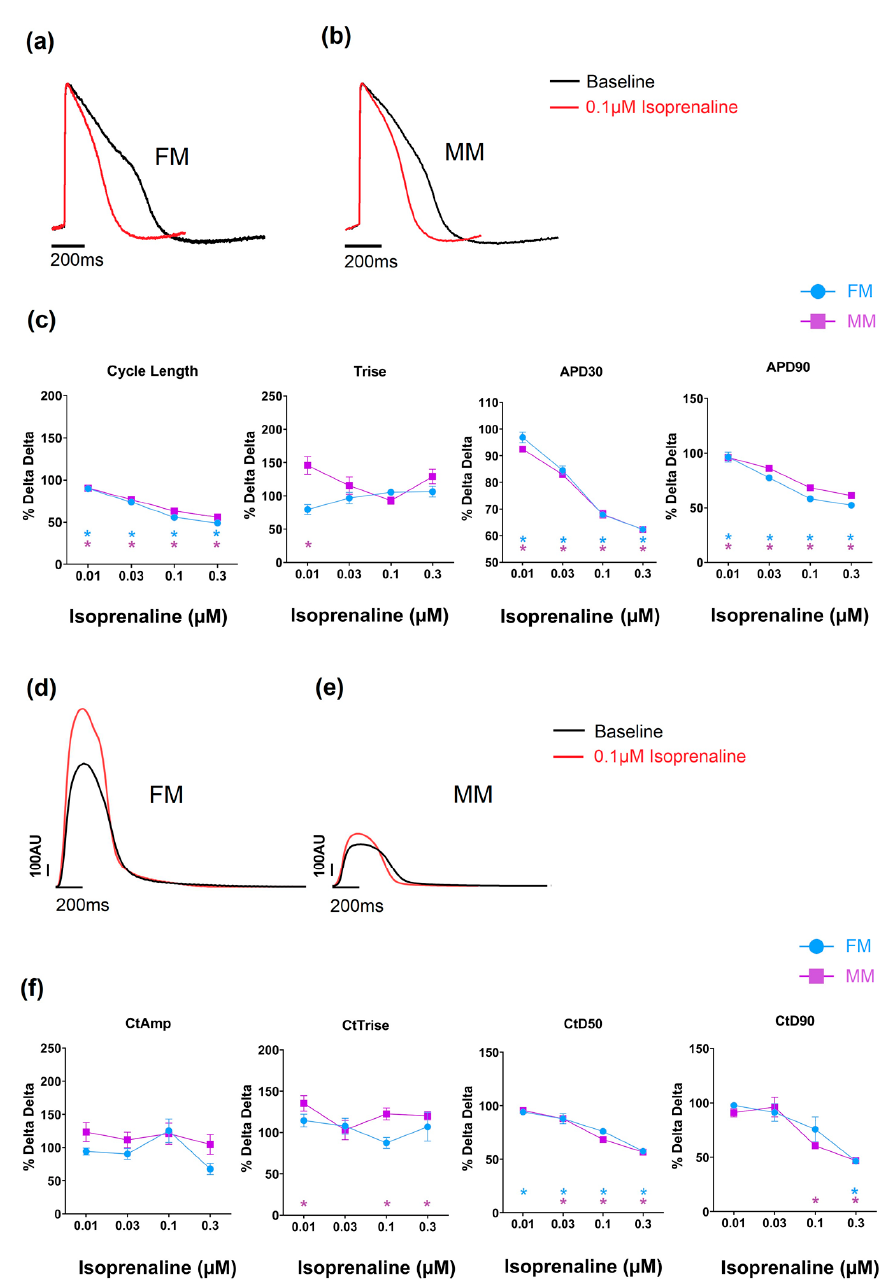
Figure 6. The effect of isoprenaline on the two models on electrophysiology ( a – c ) and contractility ( d – f ) (* p < 0.05). Fibronectin (FM) (blue) and Matrix Plus coated plates (MM, violet).